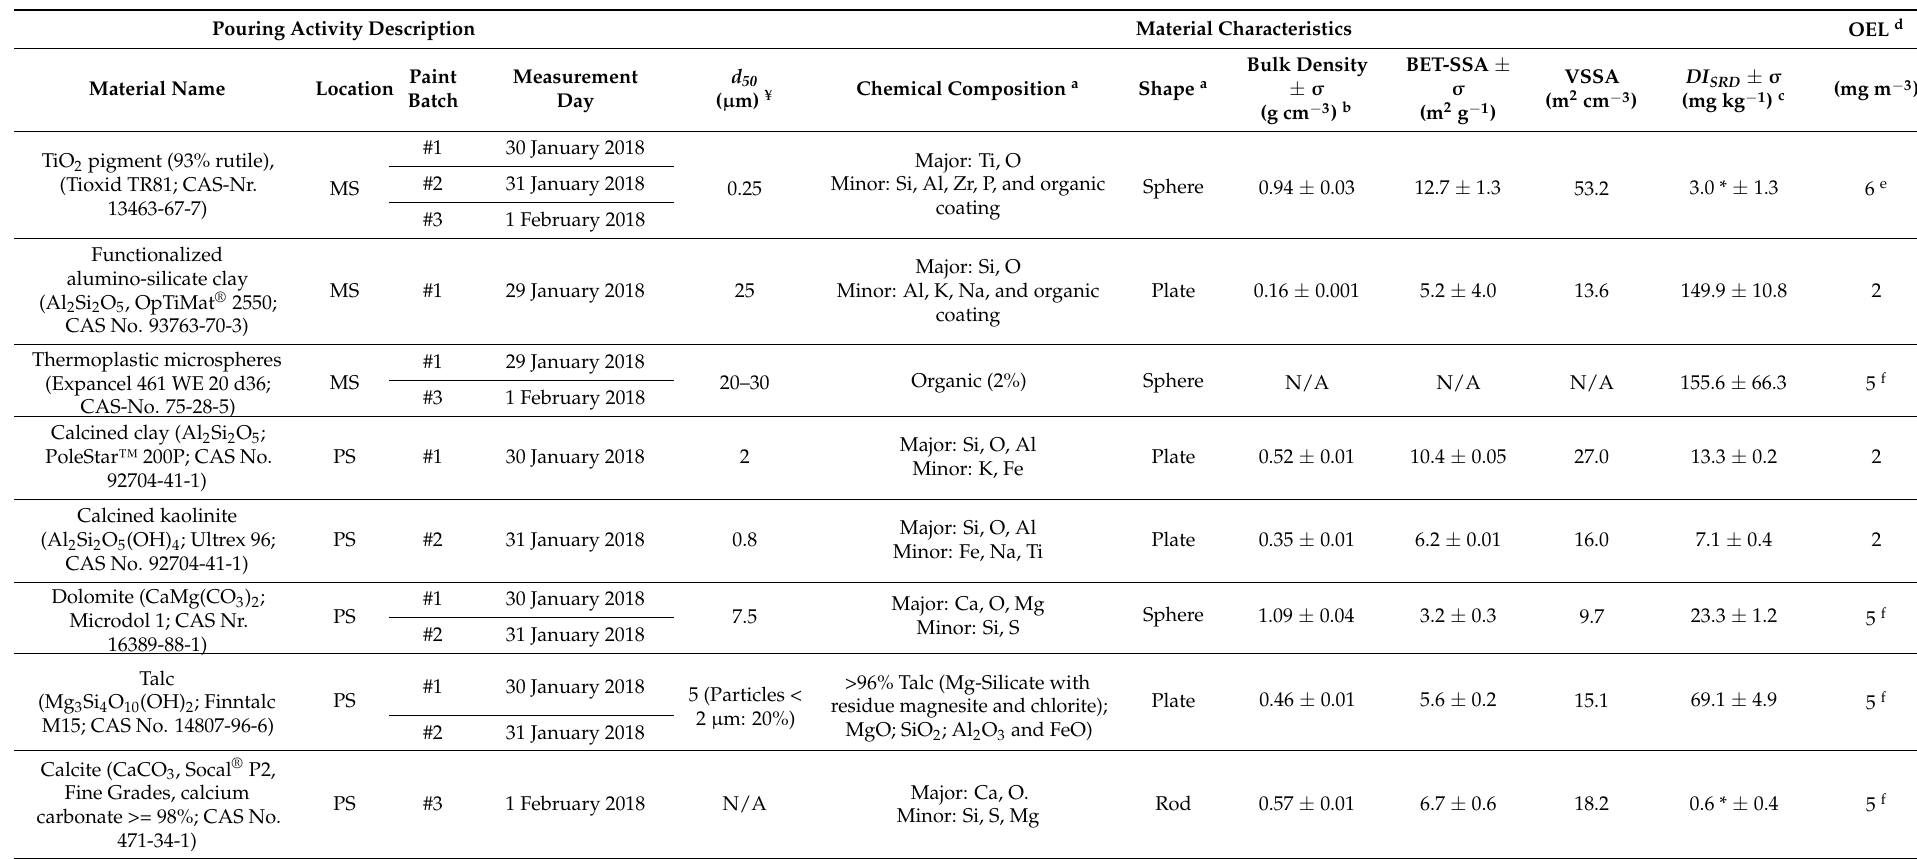
Table 1. Description of pouring activities and physicochemical characteristics of the materials under study. σ : standard deviation; d 50 : average particle size; SSA: specific surface area; VSSA: volume specific surface area; DI : dustiness index; SRD: small rotating drum method; OEL: occupational exposure